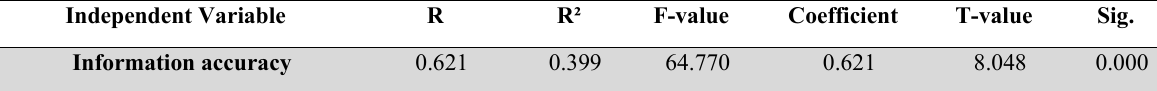
Results of SLR test of information accuracy on JRCCPE